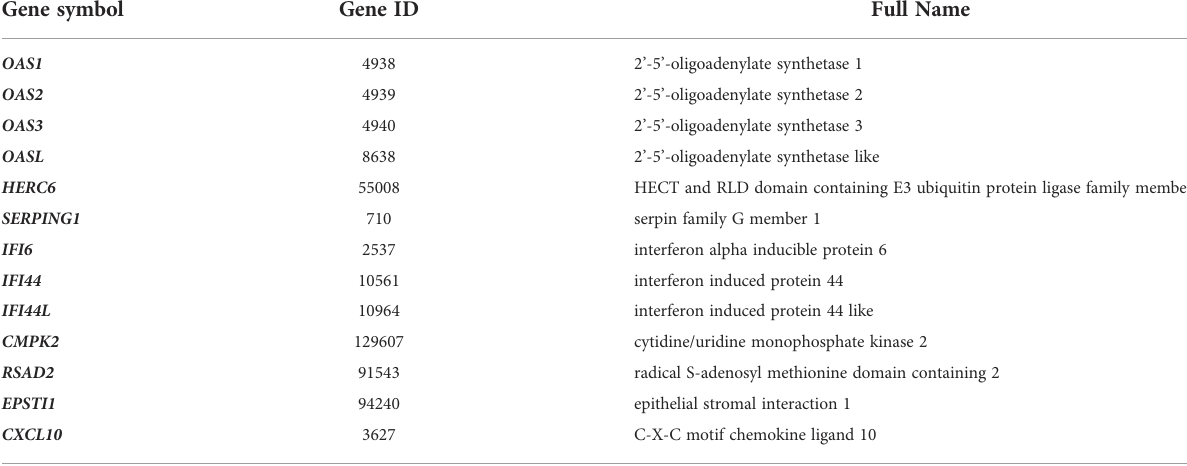
TABLE 3 The 13 genes signi fi cantly upregulated in COVID-19